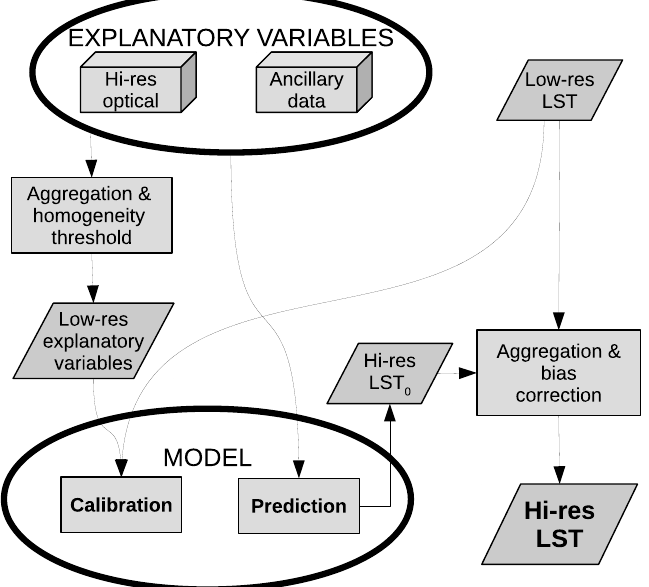
Figure 1. General thermal sharpening workflow. Explanatory variables include both shortwave bands as well any other ancillary explanatory variable, such as elevation, land cover type or exposure. Model could be any regression model, such as multivariate linear regression or machine learning